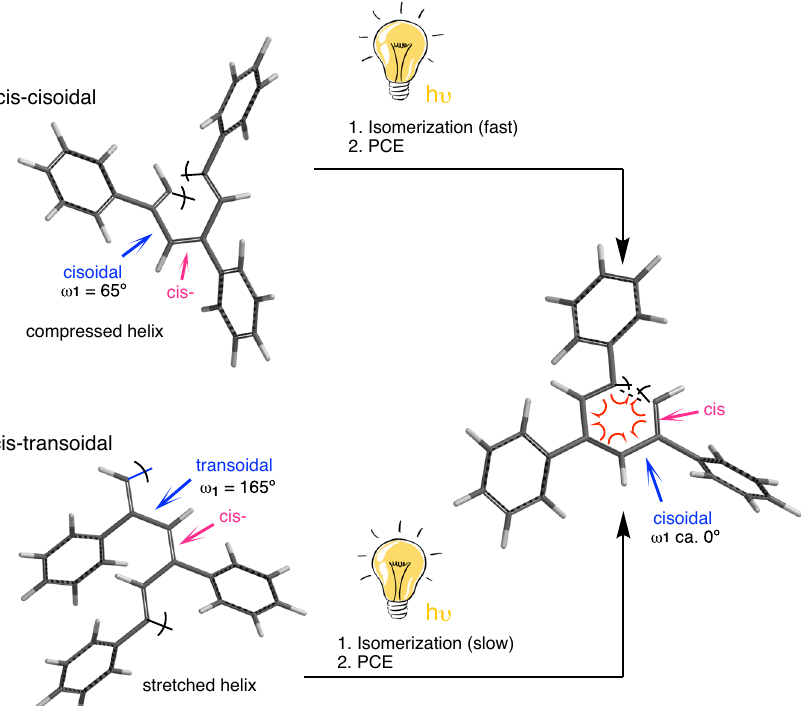
Fig. 1 | Photoisomerization process. Graphical illustration of the photoisomerization process needed in cis-cisoidal and cis-transoidal PPAs prior the photochemical